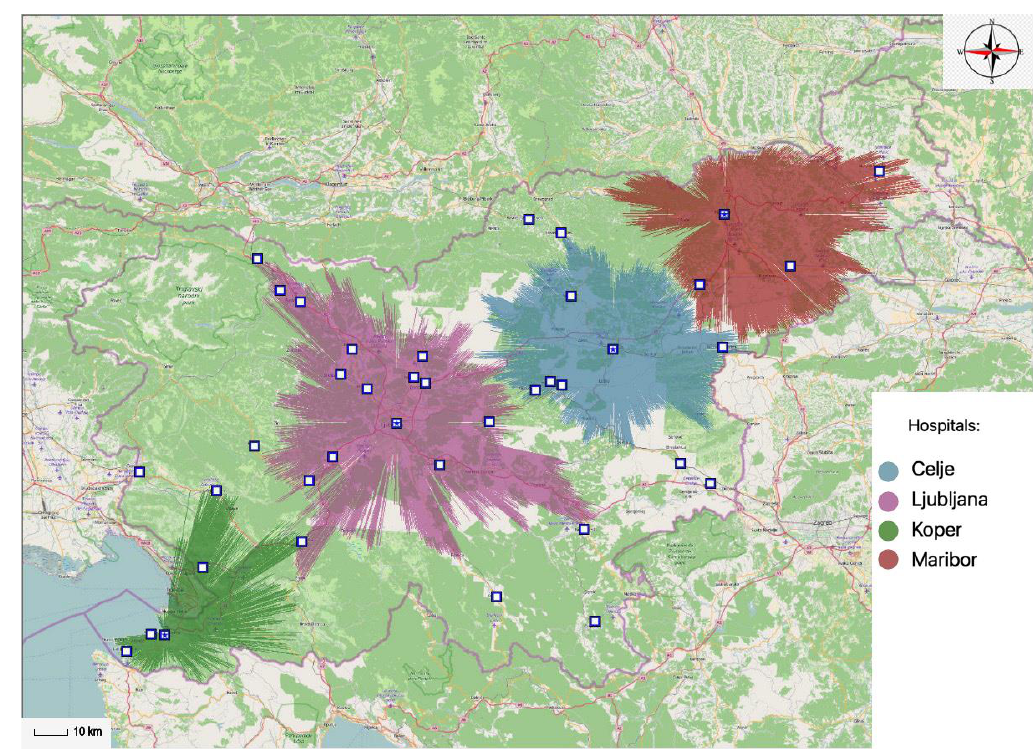
Figure 6. Optimal locations of four different general hospitals within the 45-min time interval.